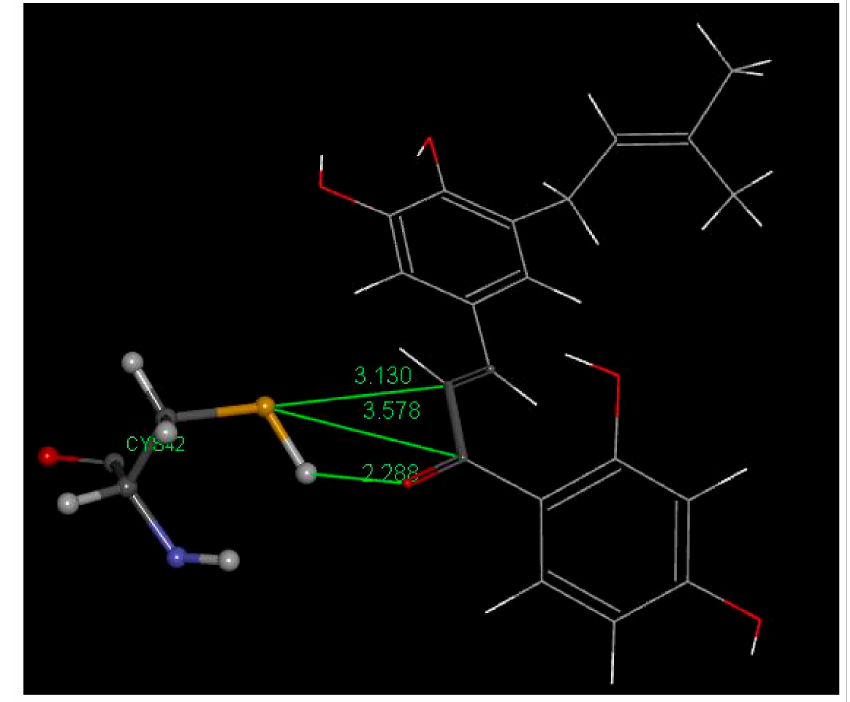
Figure 27. Pose 10, after docking 5-Prenylbutein ( 4 ) in the 3BPF receptor. A potential capture of H[S(Cys42)] by chalcone O(carbonyl), 2.228 Å, is envisioned, along with S(thiolate) nucleophilic attack to C(carbonyl), 3.578 Å, or, more probably C(ethenyl) α carbon, 3.130